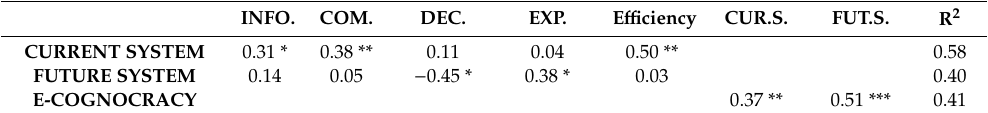
Table 9. Structural